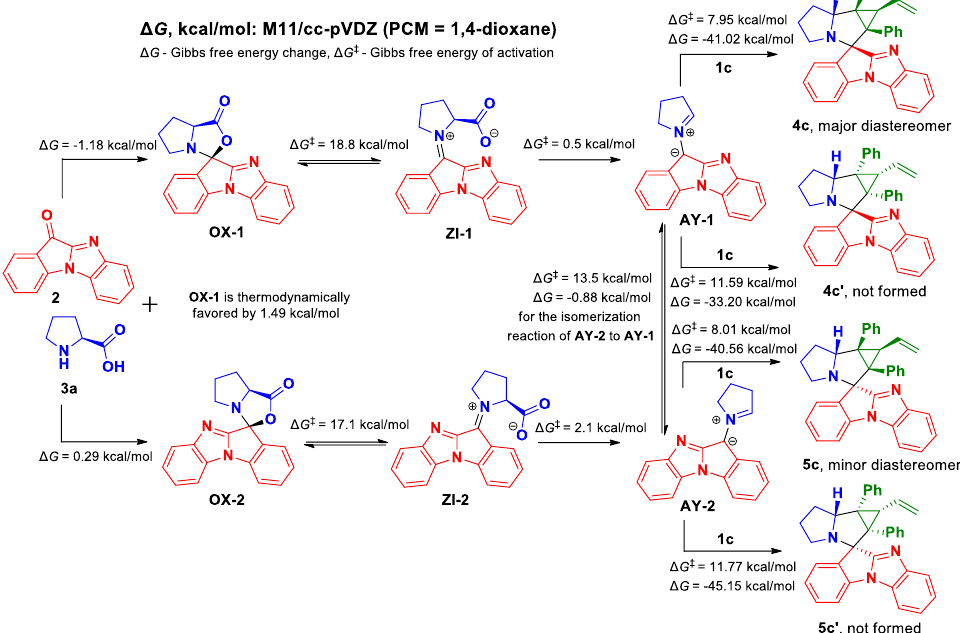
Figure 4. Plausible reaction mechanism for the reaction of 1,2-diphenyl-3-vinylcyclopropene ( 1c ), 11H-benzo[4,5]imidazo[1,2-a]indol-11-one ( 2 ), and L-proline ( 3a ).